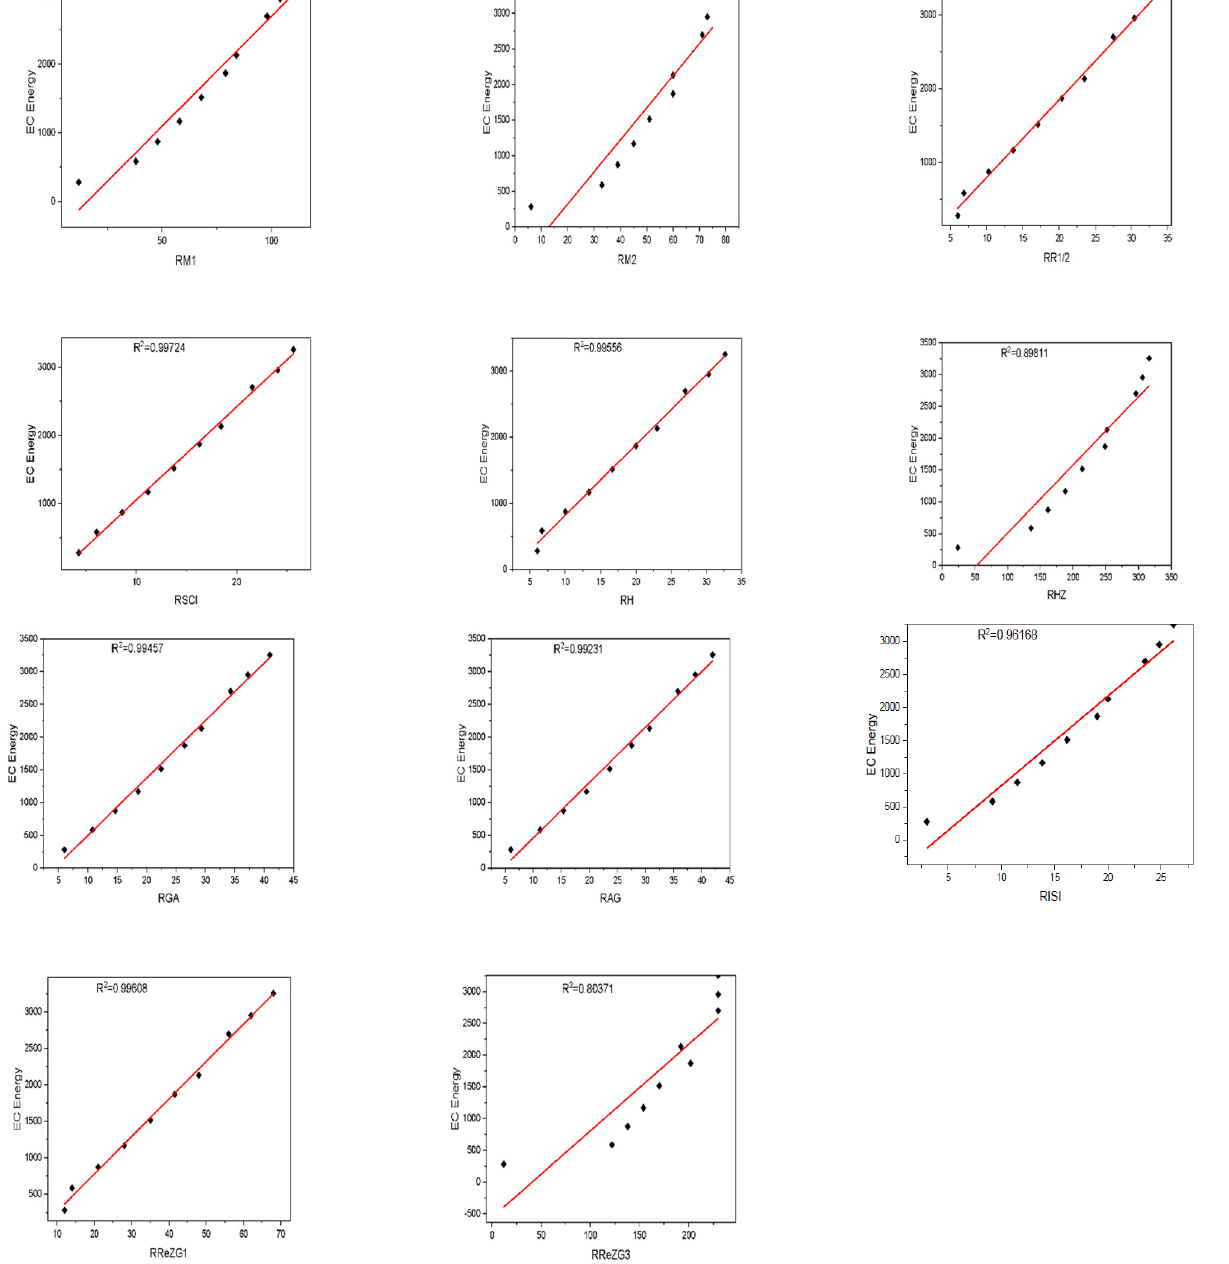
Figure 3. Plot between the reverse topological descriptors and ECE of graphene sheets from C 6 to C 32.